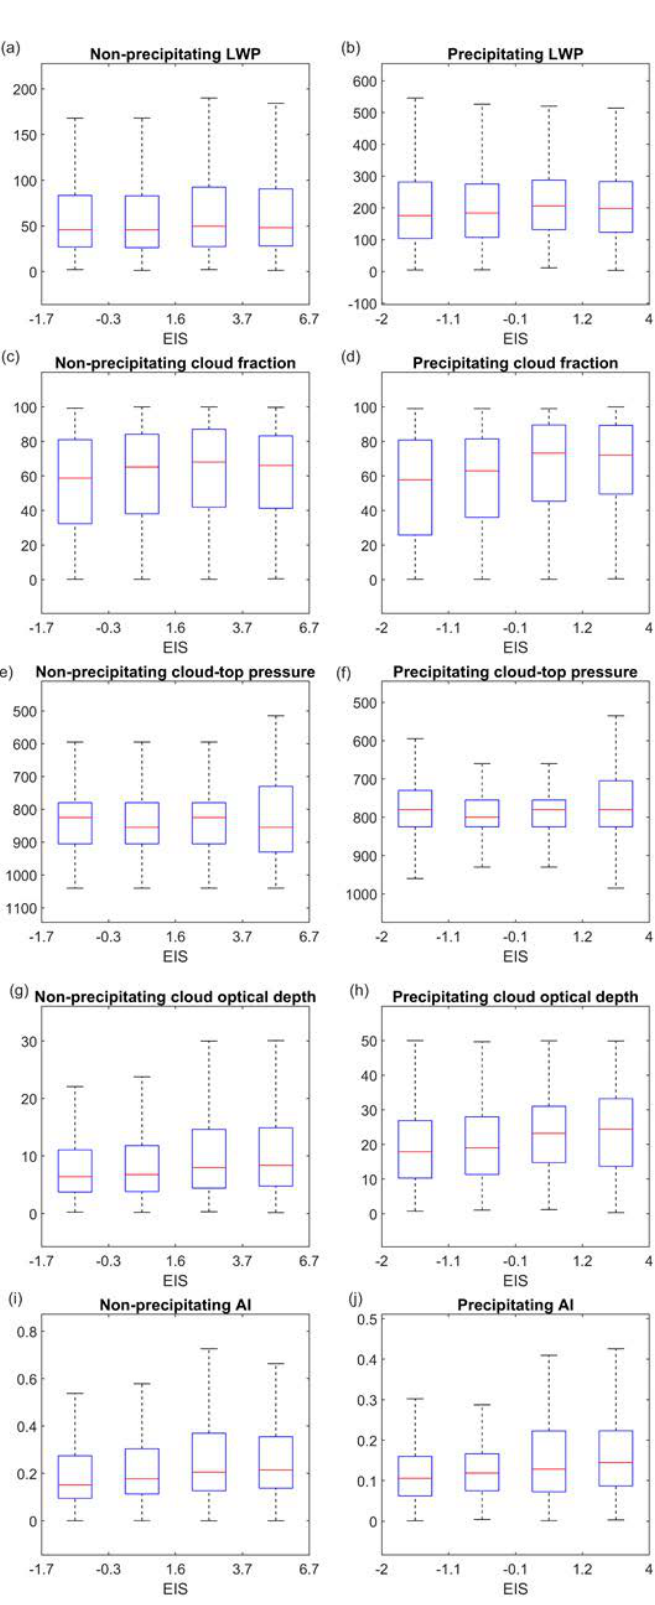
Figure 7. ( a , c , e , g , i ) For non-precipitating clouds. ( b , d , f , h , j ) For precipitating clouds. The same as Figure 6, but for different EIS bins. The numbers on the x-axis denote 10th, 30th, 50th, 70th, and 90th percentiles by